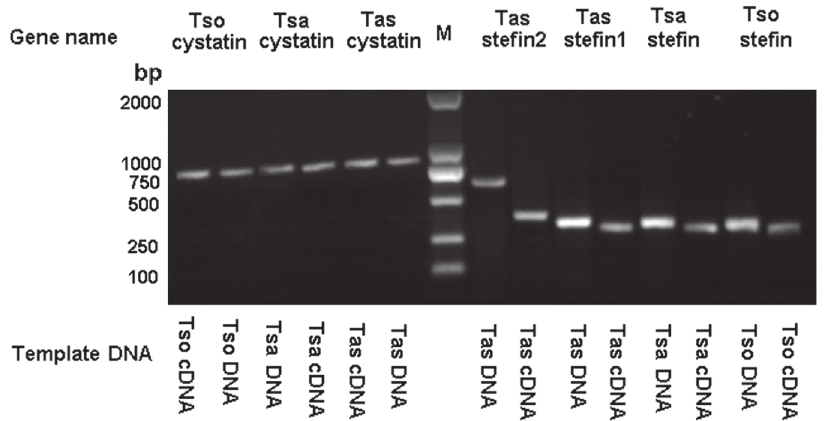
Fig 1. PCR fragments for cystatin superfamily in T . solium , T . saginata and T . asiatica . DNA and cDNAs of the three species were used as templates to amplify cystatin superfamily. The PCR products of cystatins are shown on the left of the DL2000 molecular marker, and stefins are shown on the right. (Table 2). Additionally, the intron position and length in each of the cestode stefins were iden- tical, except for T . asiatica stefin2 (Table 2). Gene organizations for the three parasite stefins were also confirmed through PCR and sequencing (Fig 1 and Table 2).